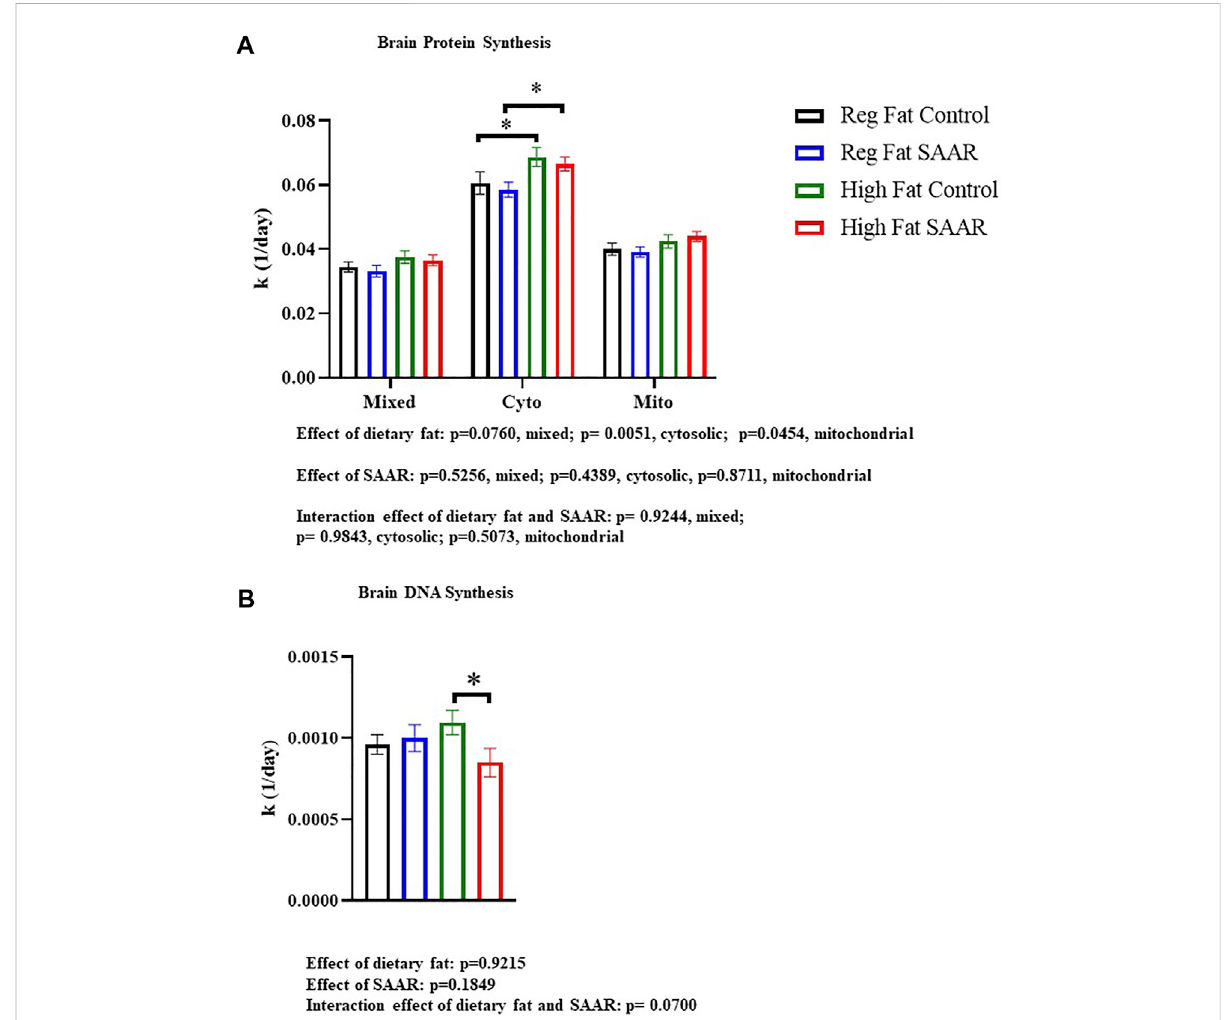
FIGURE 1 Rates of brain protein synthesis (K) in subcellular fractions and DNA synthesis in C57Bl/6J mice that were fed Regular Fat Control, Regular Fat SAAR, High Fat Control, or High Fat SAAR diets. Before starting their diets, mice were injected with a bolus of 99% 2 H 2 O and had ad libitum access to drinking water enriched with 8% 2 H 2 O. On days 1, 3, 7, 14, 21, and 35, n = 3-5 mice/timepoint were fasted for 4 hours and then sacri fi ced. A 1-phase association was used to calculatethe rate of the rise of fraction new protein and DNA over time to determinethe rate of synthesis (k, 1/d). (A) In the cytosolic and mitochondrial protein fractions, there was a main effect of dietary fat. Post hoc multiple comparisons showed that rates of protein synthesis were not signi fi cantly different in the mixed, cytosolic fractions, and mitochondrial fractions of mice fed Regular Fat SAAR and High Fat SAAR diets compared to their control diets. However, rates of cytosolic protein synthesis were greater in the High Fat Control compared to the RegularFatControl,likelyexplainingthesigni fi cantdifferencebetweenHighFatSAARandRegularFatSAAR. (B)